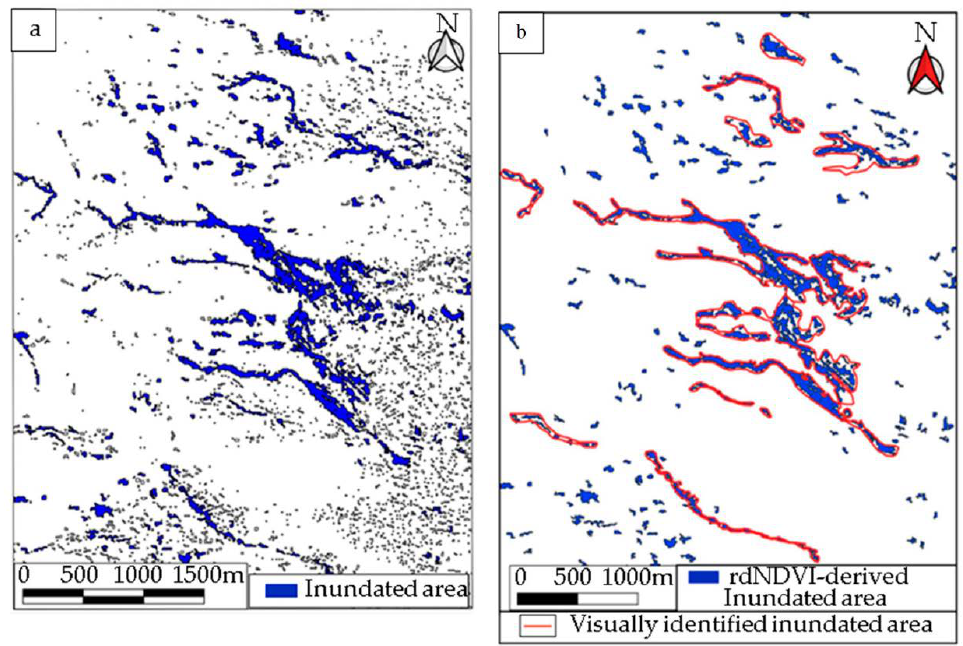
Figure 14. The extraction of inundated and non-inundated areas from the rdNDVI result based on binarization for two thresholds. ( a ) The left image presents the result of threshold binarization with unwanted salt-and-pepper noise. ( b ) In the left image, the inundated area (shown by the red lines) is superimposed on the extracted image of the threshold-binarization after removing salt-and-pepper noise.